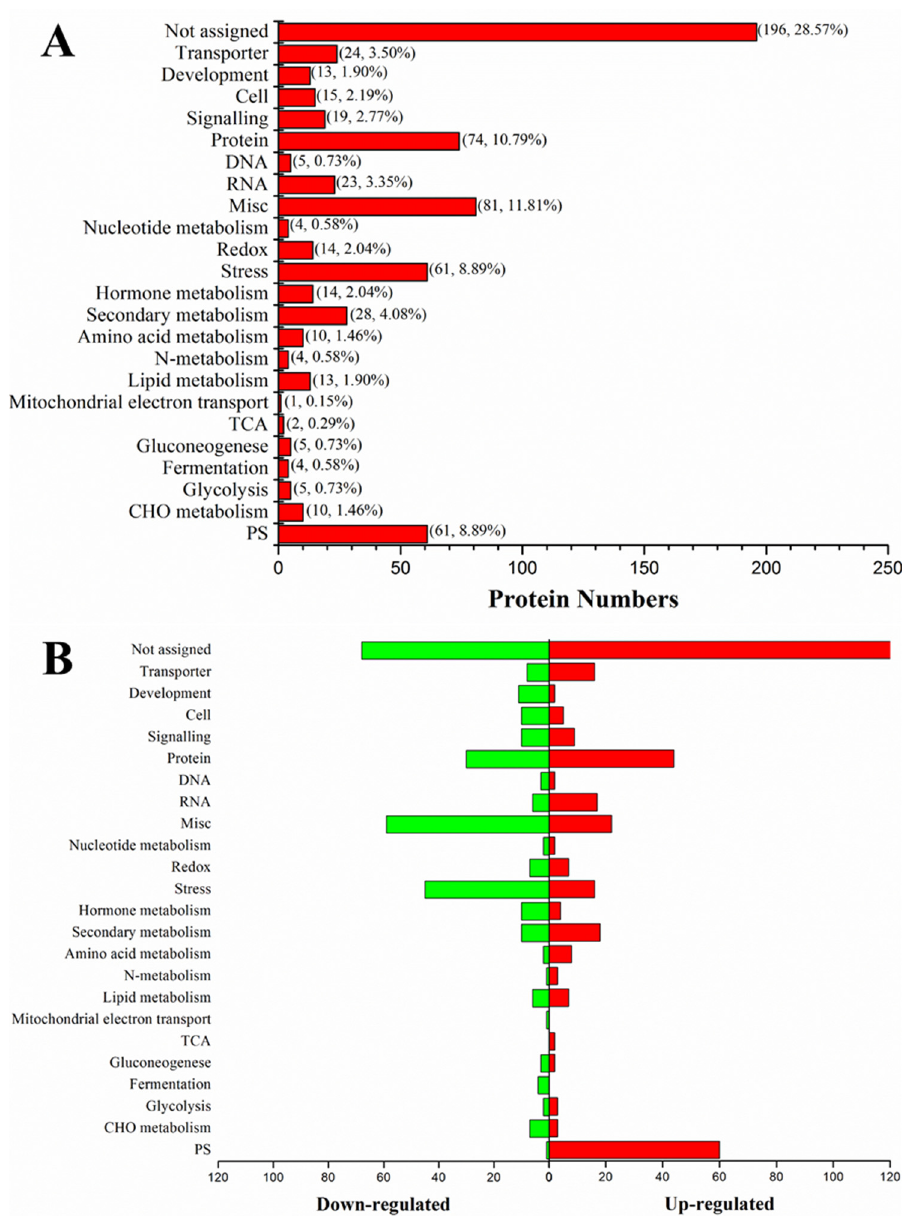
Figure 6. The functional pathway analysis of differential expression proteins in Dular-WT and Dular-OE. ( A ) Proteins function divided into 24 categories. ( B ) Sidewise bar graph depicting up-and down-regulating proteins.